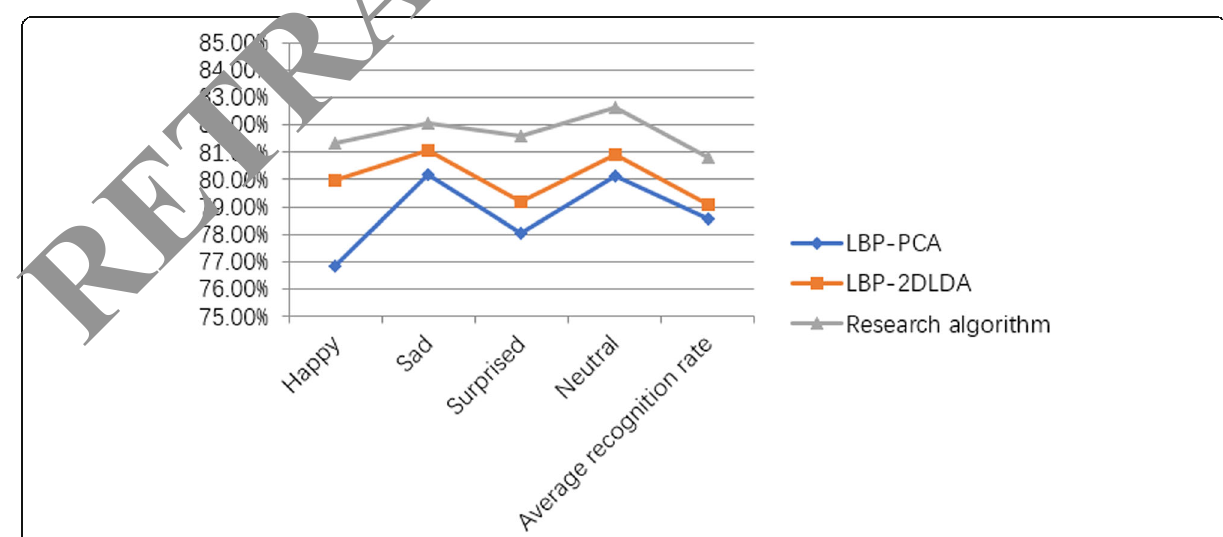
Fig. 5 Recognition rate of different facial expressions